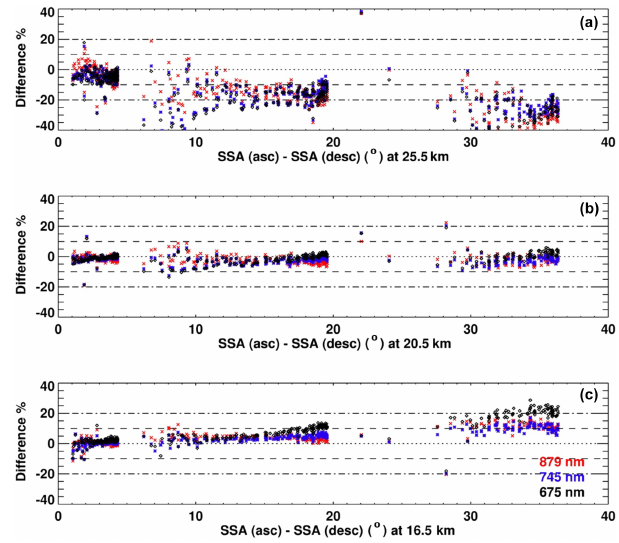
Figure 3. Scatter plot of the difference between ascending and de- scending aerosol extinction coefficient zonal means (%) for 675 (black), 745 (blue) and 869nm (red) vs. the difference of single- scattering angle (SSA) of the ascending and descending measure- ments at 25 (top), 20.5 (middle) and 16.5km (bottom). Measure- ments where the SSA difference is less than 6 ◦ are for zonal mean latitude 90–80 ◦ N, SSA difference of 6–25 ◦ is for 80–70 ◦ N and SSA difference of 25–36 ◦ is for 70–60 ◦